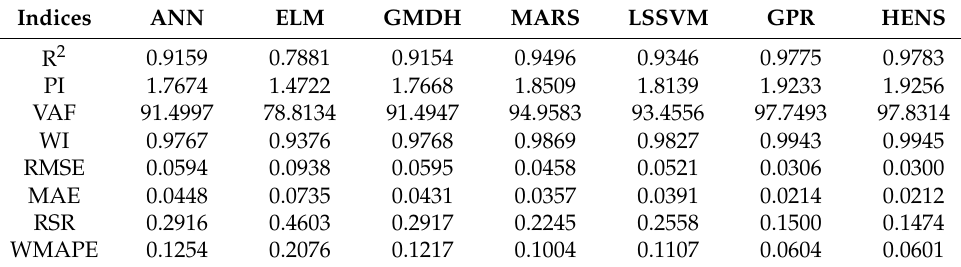
Figure 7. Tested vs. predicted graph of testing data. Table 3. Performance indices for the training